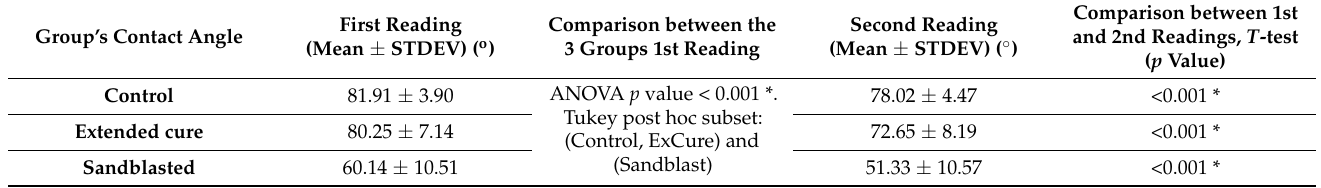
Table 2. Comparison between the three groups’ contact angle measurements at first reading (30 s). Comparison of each group’s measurement after 2-min time lapse (comparing first to second